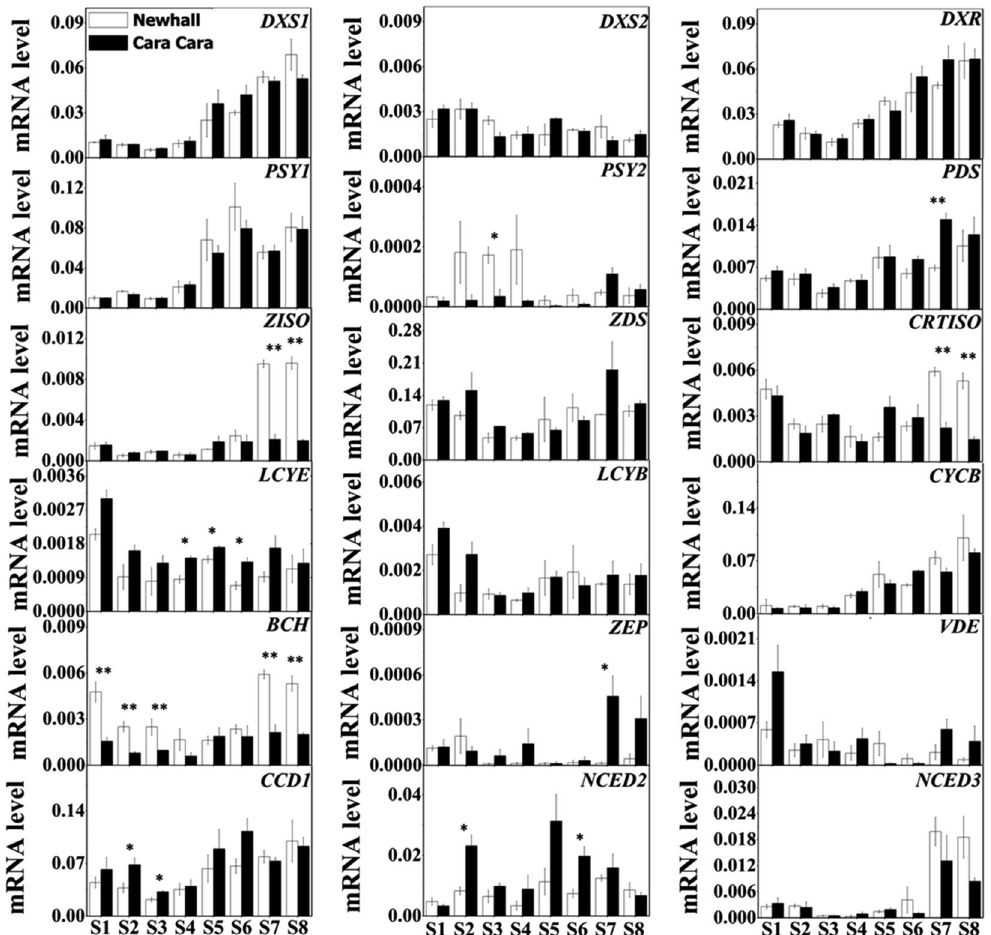
Figure 7. Expression of carotenogenic genes in flesh of Newhall and Cara Cara oranges during fruit development and ripening. The bars represent SE from three biological replicates . Asterisks indicate significant differences, P < 0.05 and P < 0.01 are designated by * and ** , respectively. The abbreviation for the genes is the same as listed in Fig.